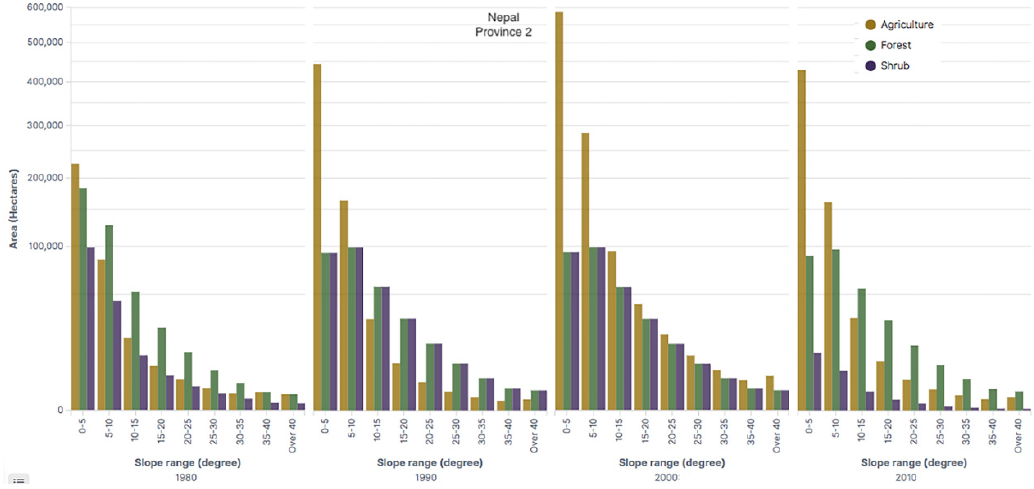
Figure 13. Province 2: forest, shrubland, and agricultural areas of Nepal by 9 elevation classes for 1980, 1990, 2000, and 2010. Table 8. Province 2: land use as a percentage of total area of forest, shrubland, and agriculture for 1980, 1990. 2000, and 2010 for entire Nepal. ((Individual land-use area for a slope class/sum of forest + shrubland + agriculture) * 100).